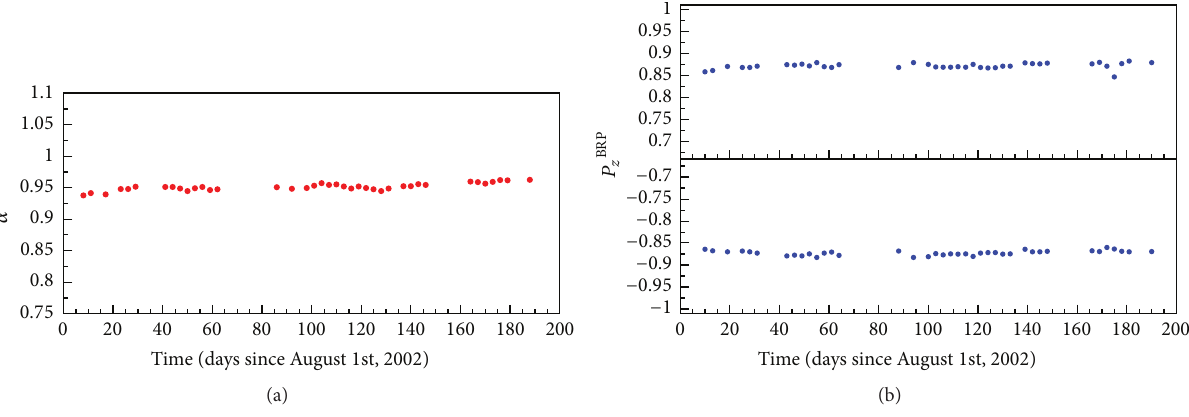
Figure 2: Results of the target analysis for the HERMES 2002/03 data taking period with transverse proton polarization as number of days, since August 1, 2002 (taken from [8]): (a) degree of dissociation 𝛼 measured by the TGA ( 𝛼 = 1: no molecules); (b) positive and negative vector polarization 𝑃 𝑧 of the sampled atomic part as measured by the BRP. During data taking the states of opposite sign are set periodically with a cycle time of the order of